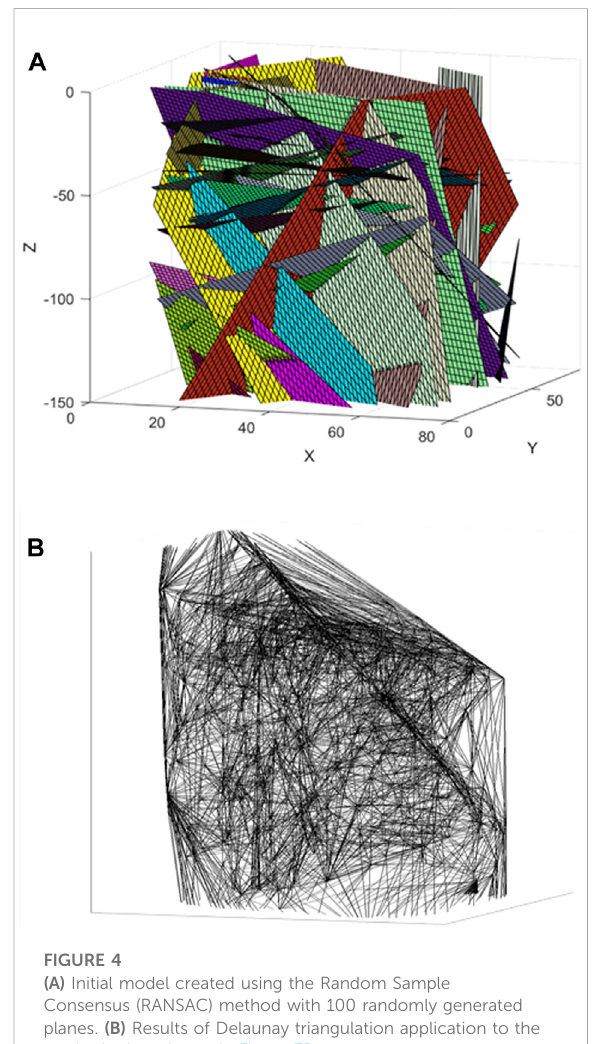
FIGURE 5 (A) Result of the re-estimated model in the fi rst